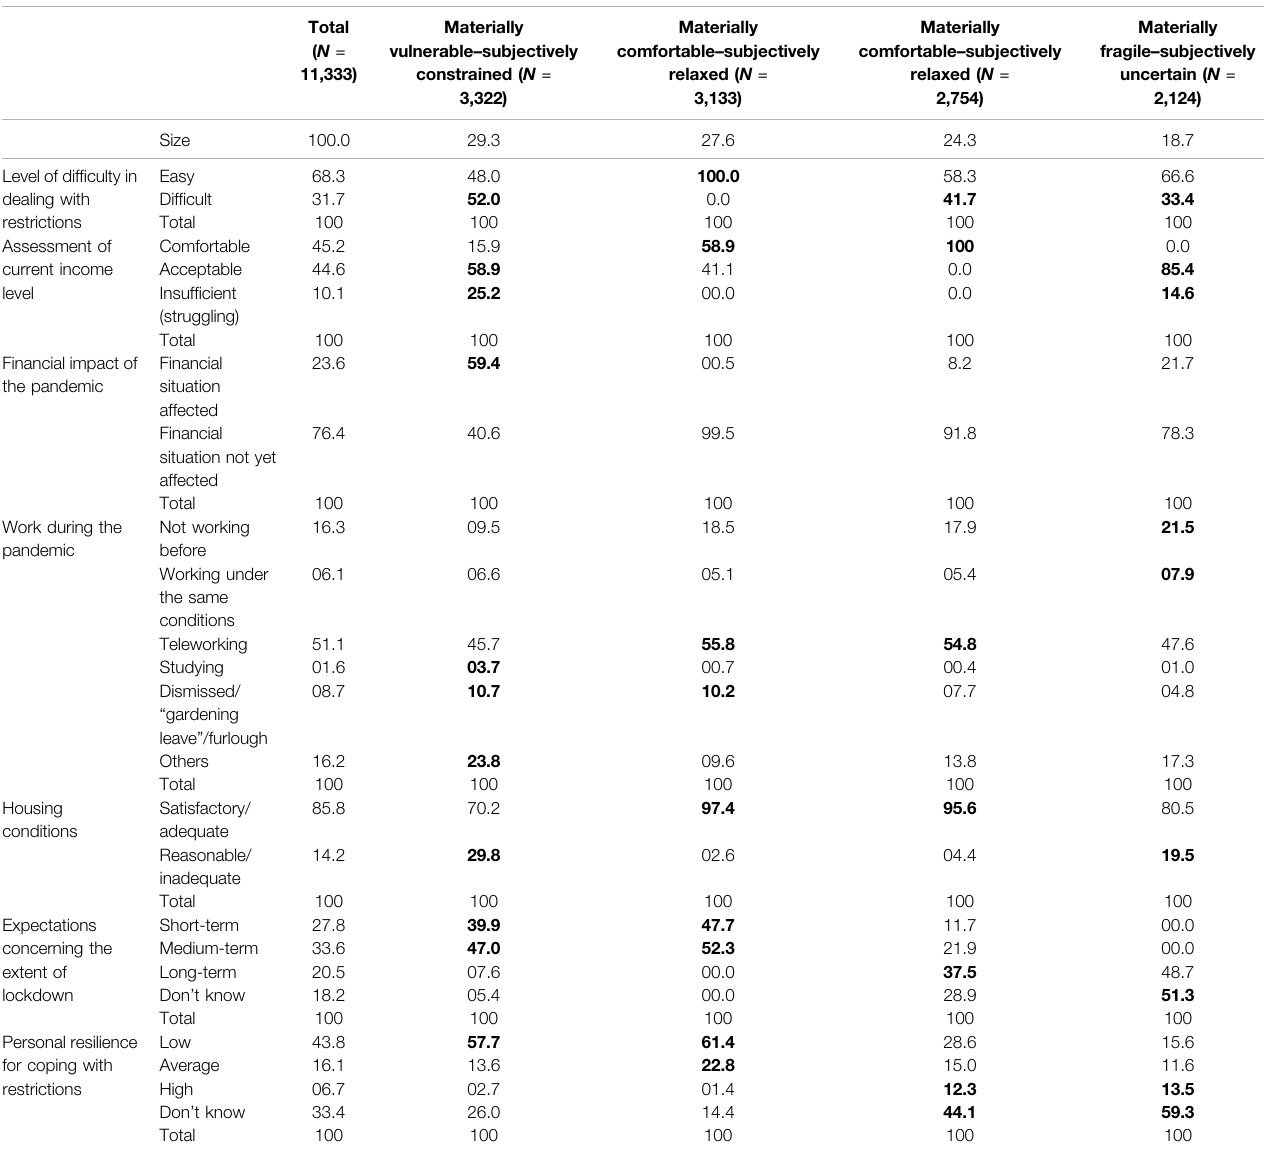
TABLE 3 | Four pro fi les of social impact (based on distribution of active variables) (in %).